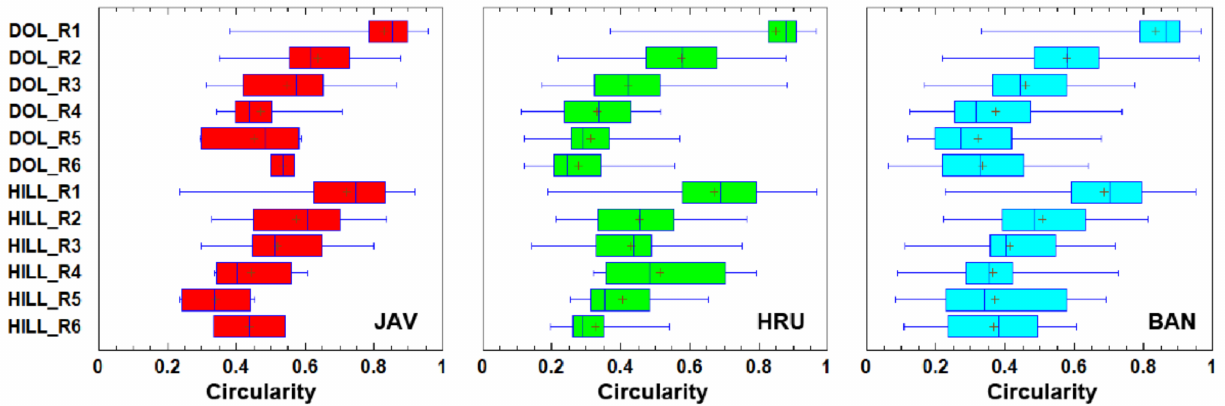
Figure 11. Box-whisker plots of doline and hill circularity values. The plus signs denote the mean values of the distributions. The boxes mark the ranges between the lower and upper quartiles. JAV: Javorniki; HRU: Hrušica; and BAN: Banjšice.